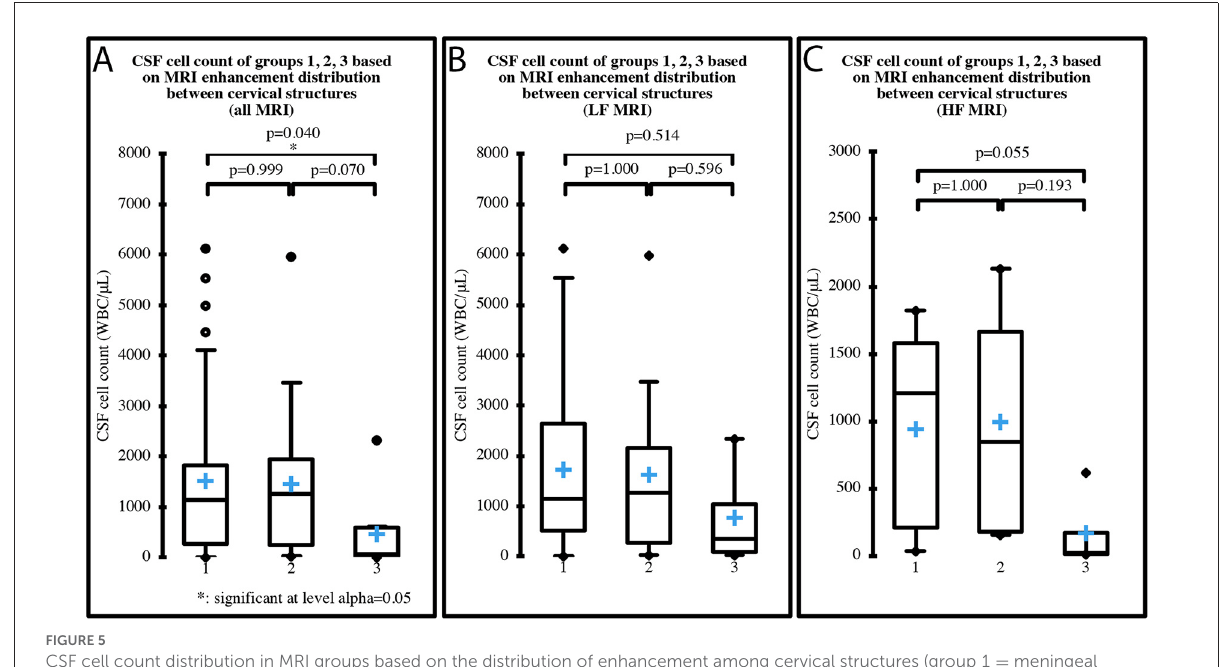
FIGURE5 CSF cell count distribution in MRI groups based on the distribution of enhancement among cervical structures (group 1 = meningeal enhancement concurrently with synovium of the articular facets and/or muscular enhancement, group 2 = meningeal enhancement alone, group 3 = synovium of the articular facets and/or muscular enhancement). One case had normal MRI and was therefore not included in the analysis, which was performed on all 69 MRI (A) , on the 49 LF MRI (B) and on the 20 HF MRI (C) . Boxes contain values from 1st to 3rd quartile, lines inside boxes indicate median values, crosses inside boxes indicate mean values, endpoints of vertical lines are proportional to the interquartile-deviation and dots outside “whiskers” represents outlier values.